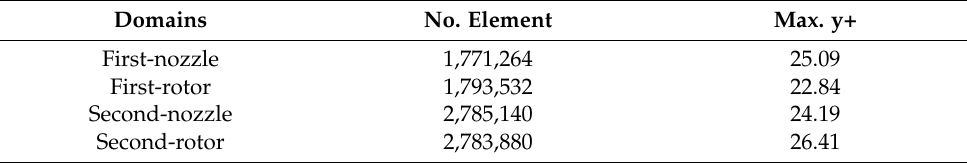
Figure 16. Mesh independence test of the final geometry. Table 7. Information of the final grid.